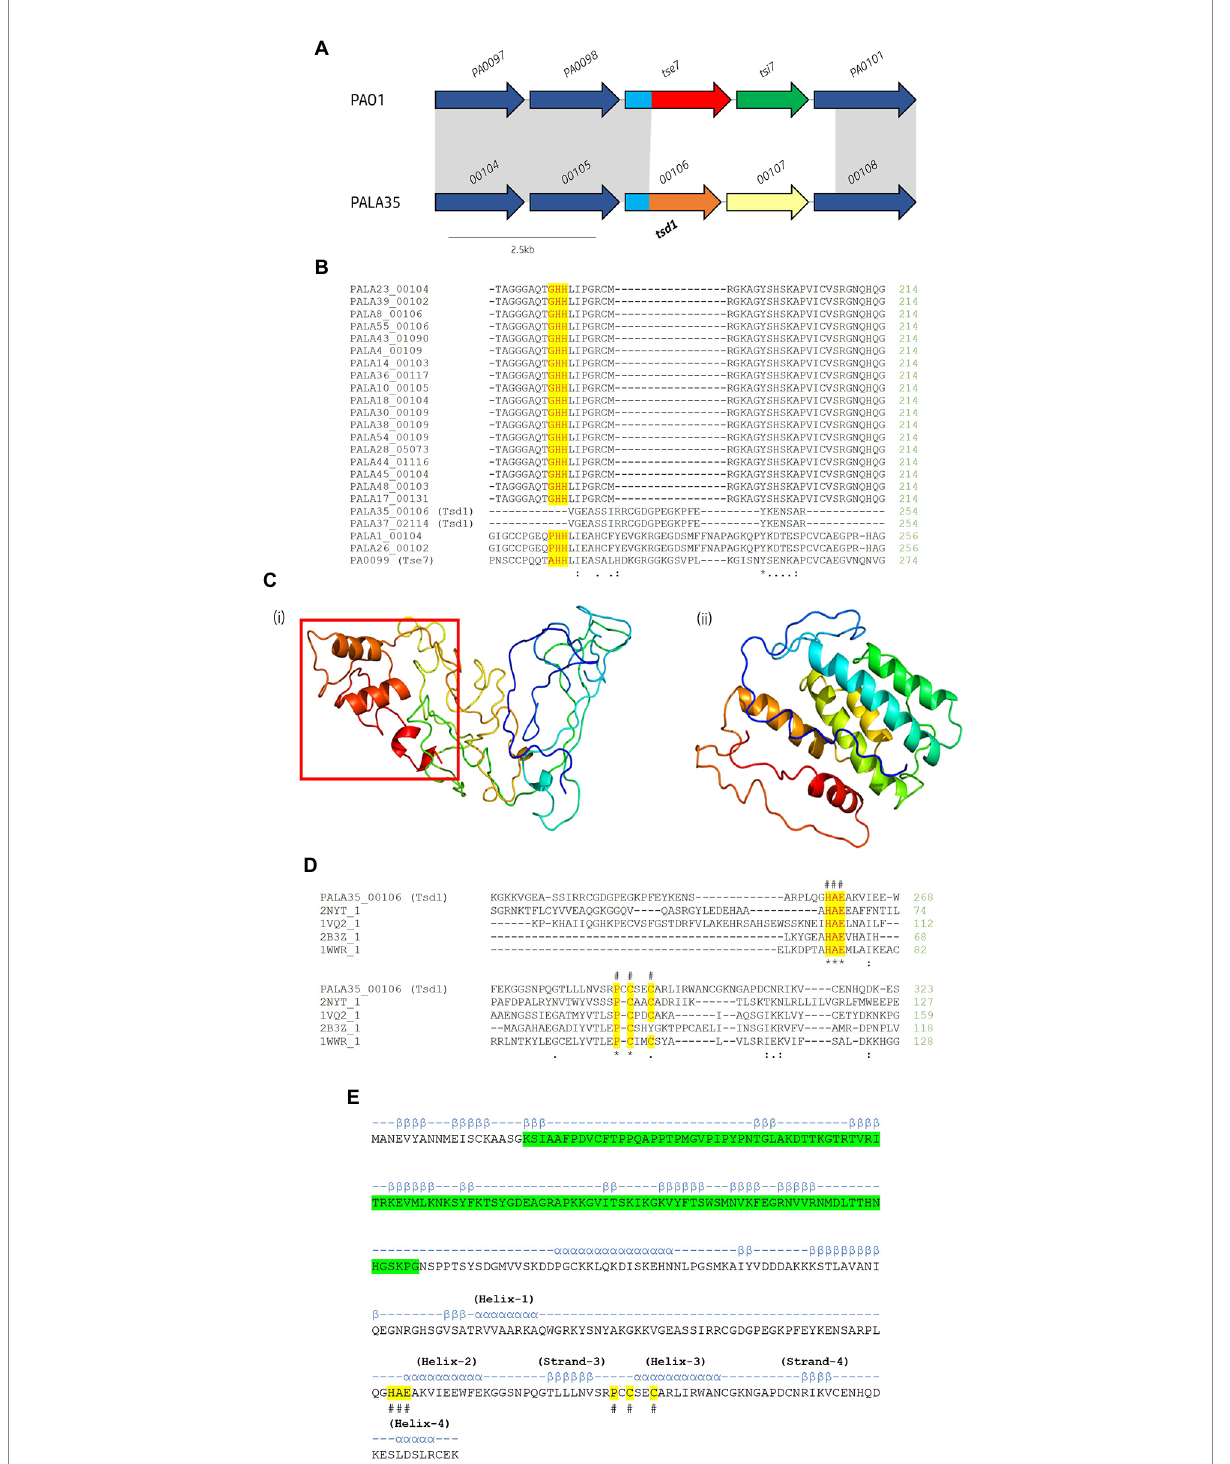
FIGURE 10 In silico analysis of putative cytidine deaminase Tsd1. (A) Schematic of the orphan effector-immunity island tse7 - tsi7 in reference P. aeruginosa and representative clinical isolate PALA35. Homologous genes are connected by grey bands. Proteins of unknown function are coloured dark blue. The N-terminal PAAR-like domain DUF4150 is light blue [aa 1-135]. The variable C-terminal is coloured red for the domain Tox-GHH2 in PA0099/ tse7 [aa 135-315] and light brown for the C-terminal cytidine deaminase domain in PALA35_0106/tsd1 [aa 135-331]. Cognate immunities are coloured green for PA0100/tsi7 and yellow for PALA35_0107/tsdI1 . (B) Partial amino acid sequence alignment of Tse7 homologs from the clinical isolates to Tse7 (PA0099) from reference strain PAO1. Residues of the characteristic GHH motif of Tox-GHH2 are highlighted yellow. Note the absence of the GHH motif from PALA35/36 Tsd1 suggesting Tsd1 has a different mechanism of action (C) Phyre2 predicted models of (i) Tsd1